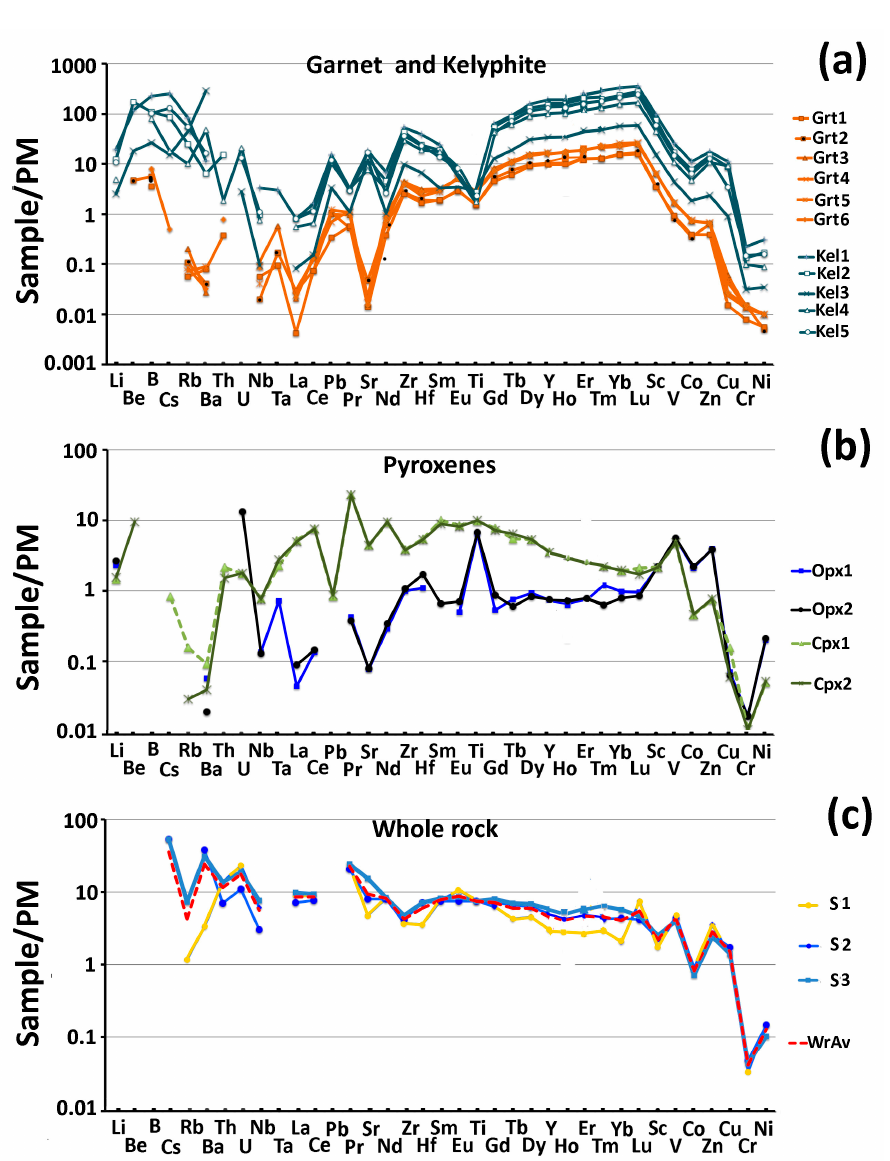
Figure 5. Multielement distribution patterns normalized to primordial mantle composition (PM) [48] of the sample whole rock and garnet, kelyphite and pyroxenes compositions. ( a ) Results of Laser-Ablation spot analyses on garnet grains (Grt1–Grt6) and Kelyphite (K1–K5). ( b ) Representative compositions of clinopyroxene (Cpx) and Ca-poor pyroxene (Opx). Numbers correspond to spot analyses as indicated in Figure 2a. ( c ) Whole-rock composition of sub-samples S1, S2, S3 and their average values (WrAv). More explanation is given in the text.